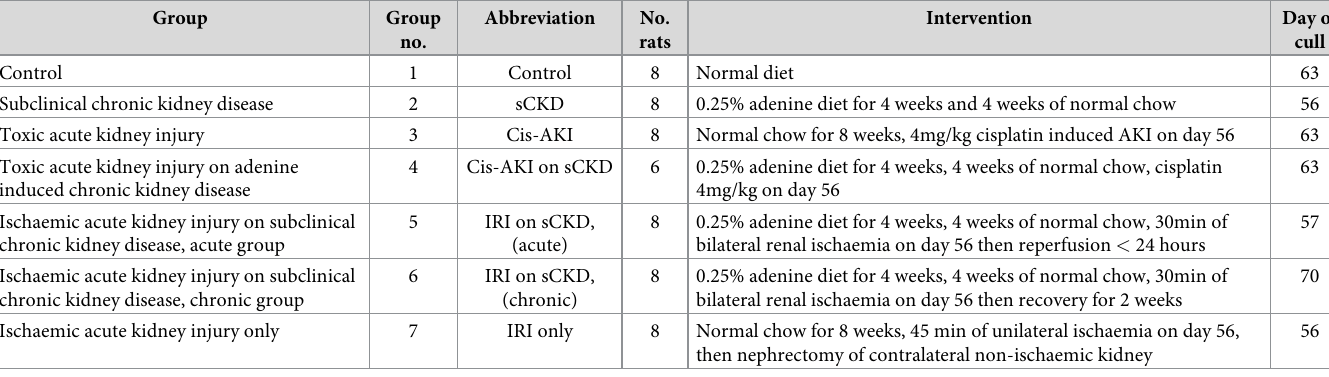
Table 15. Experimental groups and interventions.